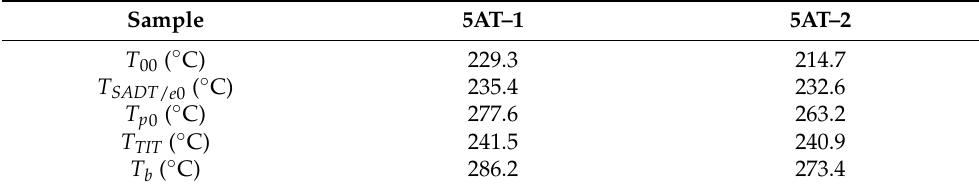
Table 5. The derivative parameters of 5-AT-1 and 5AT–2